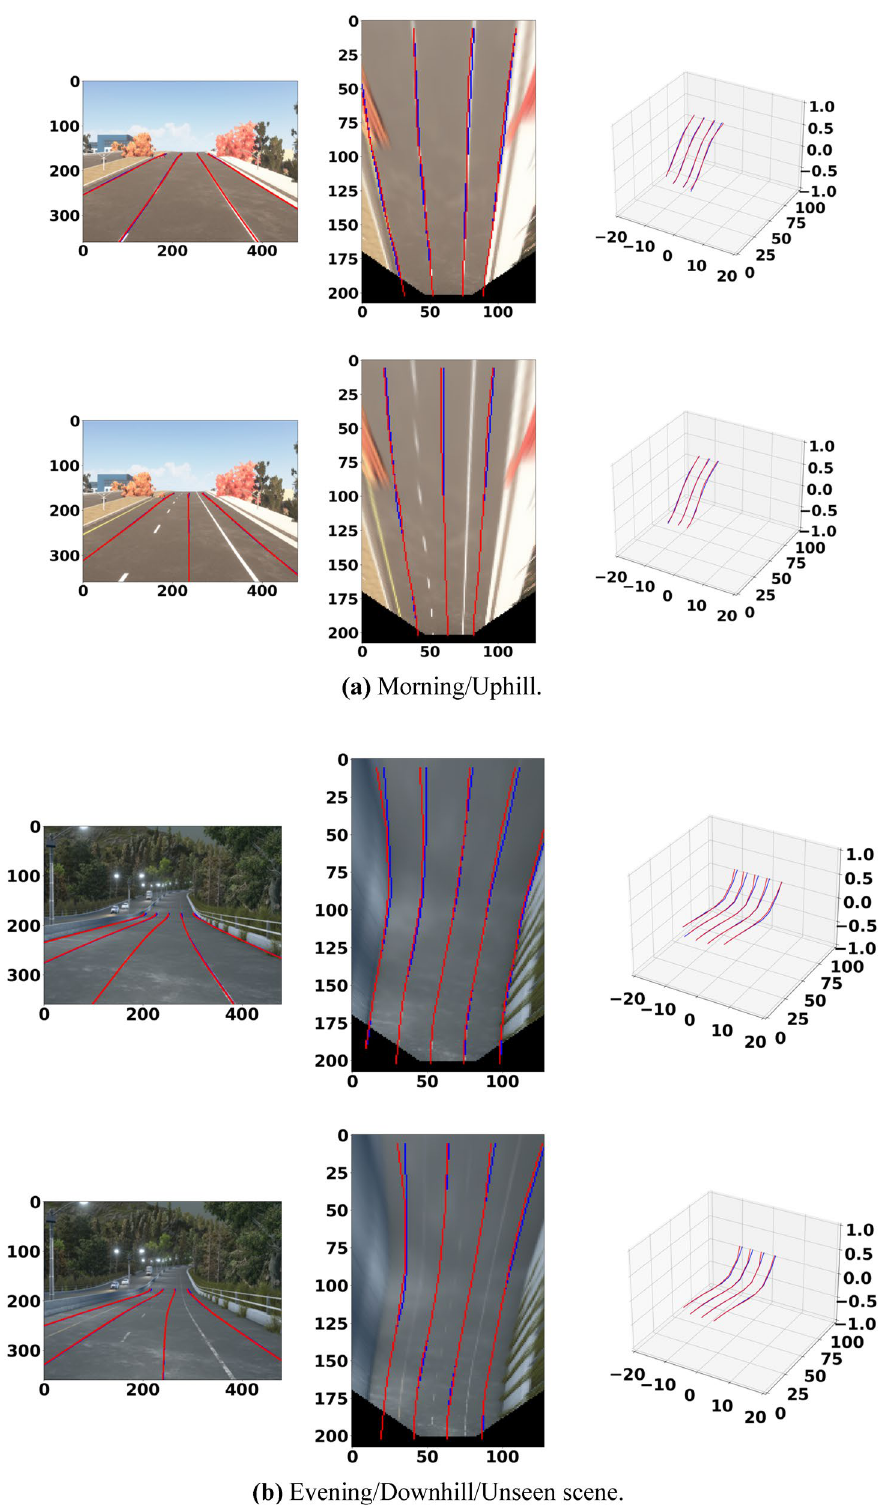
Figure 9. Examples of 3D lane detection prediction. The modeling results of Att-Gen-LaneNet performed by Python 3.7 and PyTorch